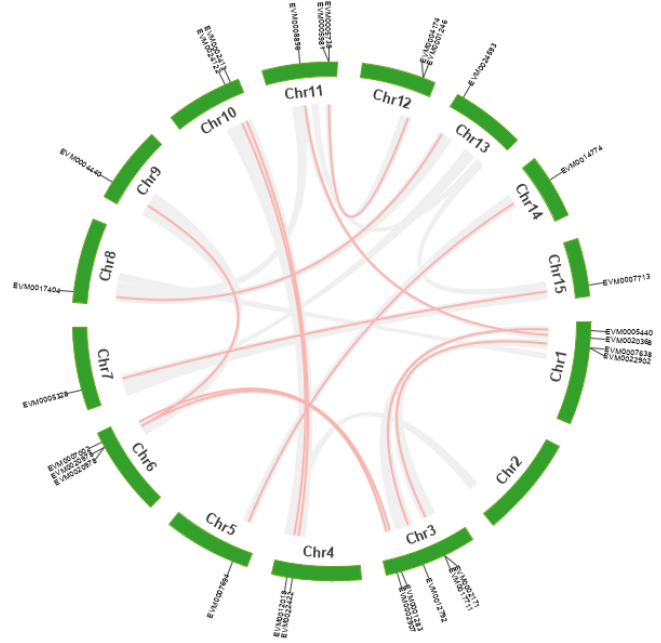
Figure 4. Schematic diagram of the relationship between AP2/ERF TFs in yellow horn. The visualization of all AP2/ERF family repeat gene pairs in chromosome Chr1-15 was performed using Circos. The gray lines in the figure represent collinear blocks, and the red lines represent repeated AP2/ERF gene pairs with collinear relationships in yellow horn.